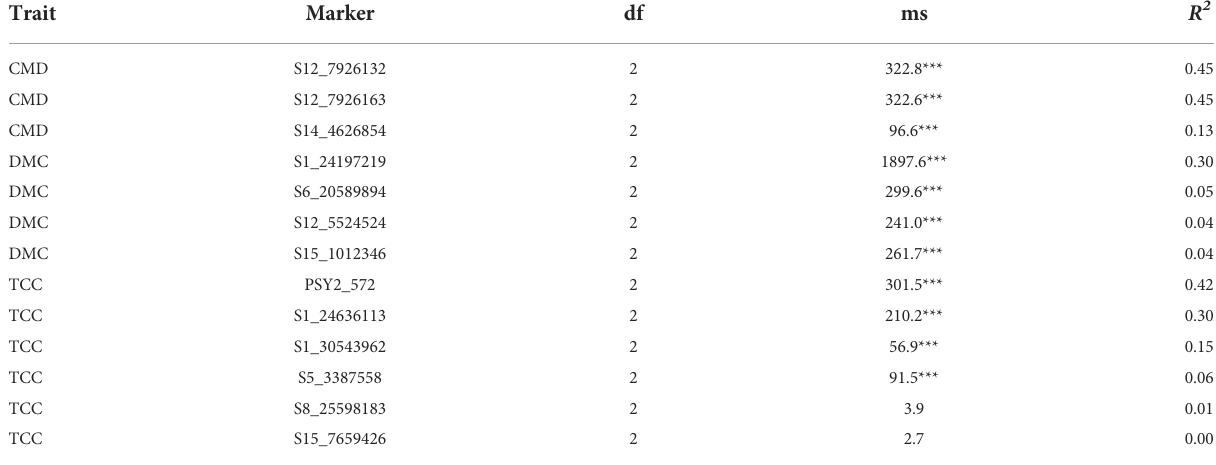
TABLE 3 Regression coef fi cients for 13 KASP markers tested for CMD, DMC and TCC in Ugandan cassava germplasm. Trait